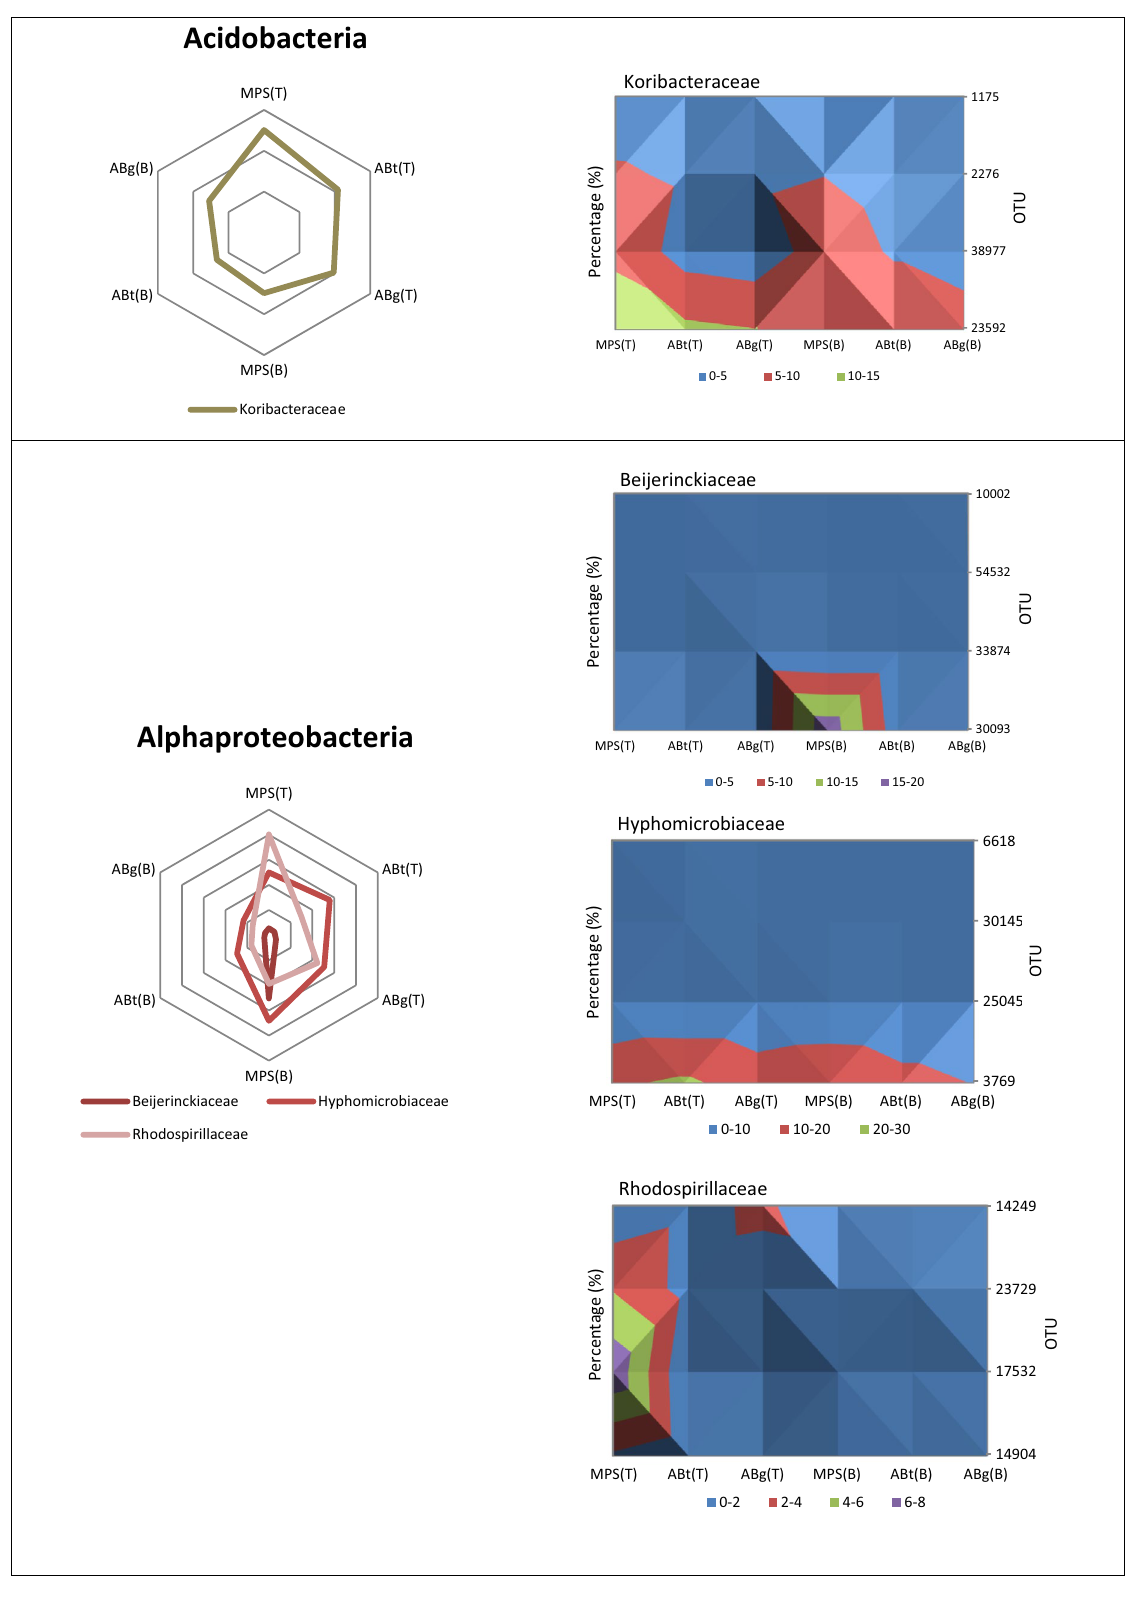
Figure 5. Distribution of selected prokaryotic community phyla and major operational taxonomic units (OTUs) in MPS, ABt and ABg forests. Percentage of the major OTU is calculated based on the relative abundance in their respective